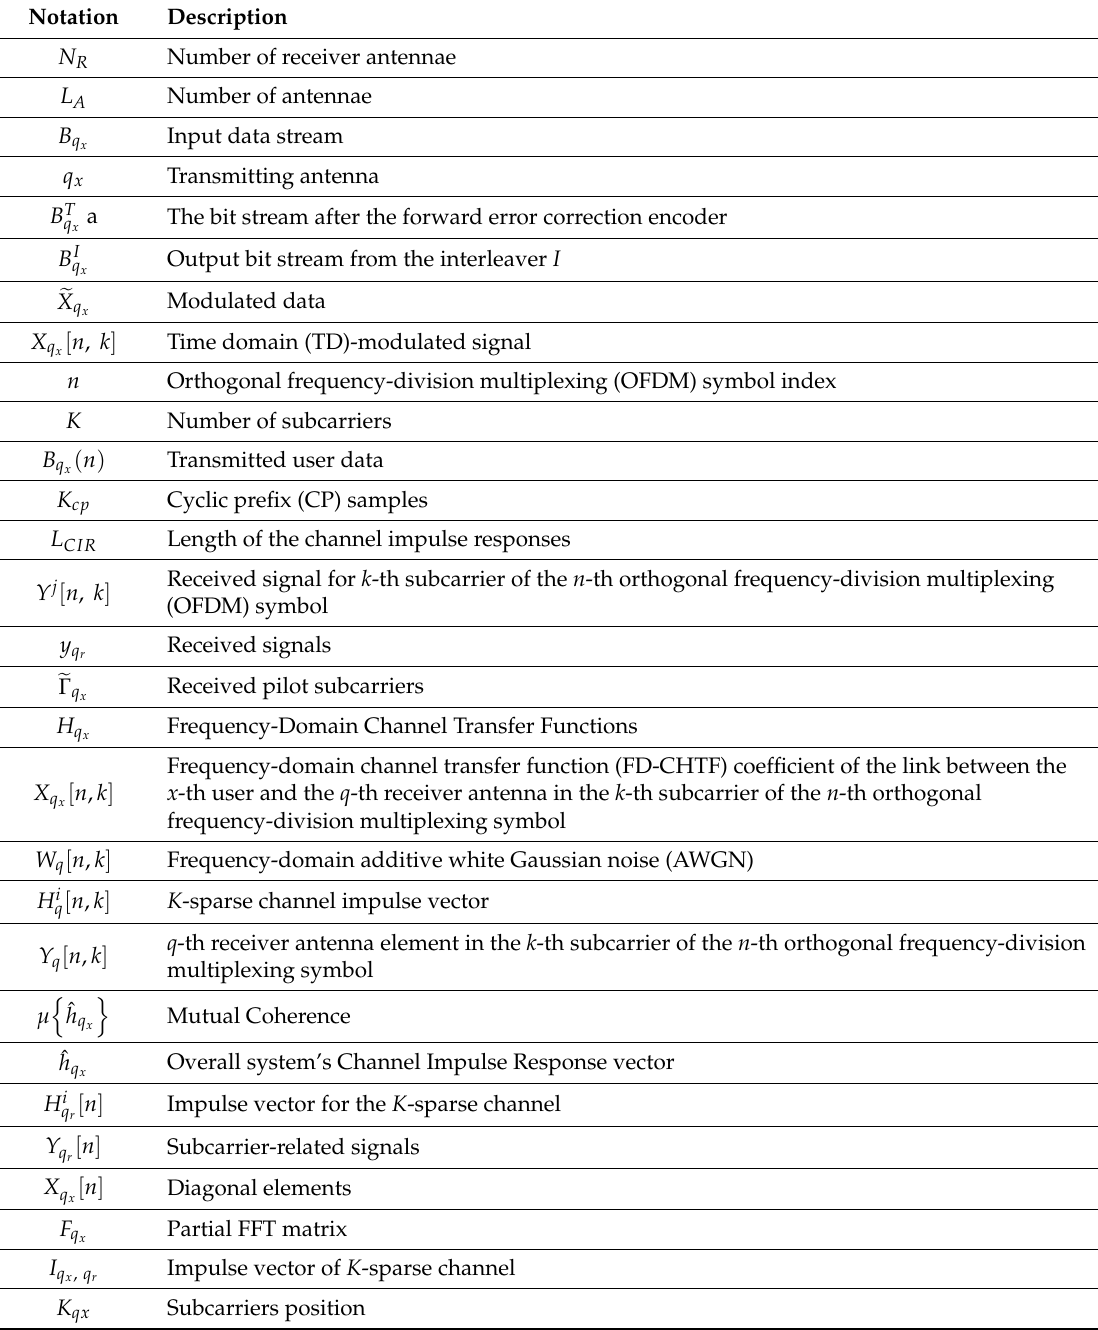
Table 1. Nomenclature of the system architecture of the entire